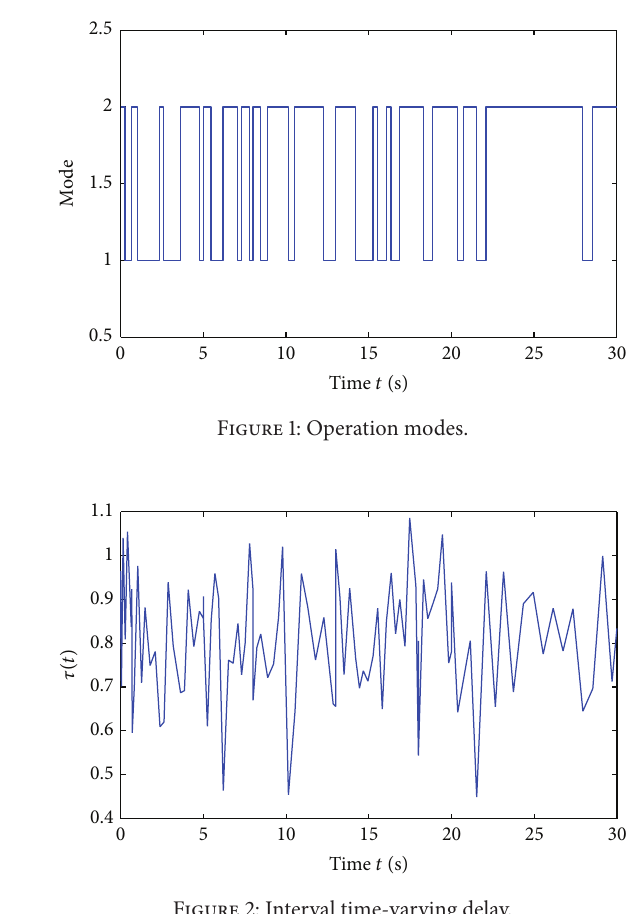
Figure 2: Interval time-varying